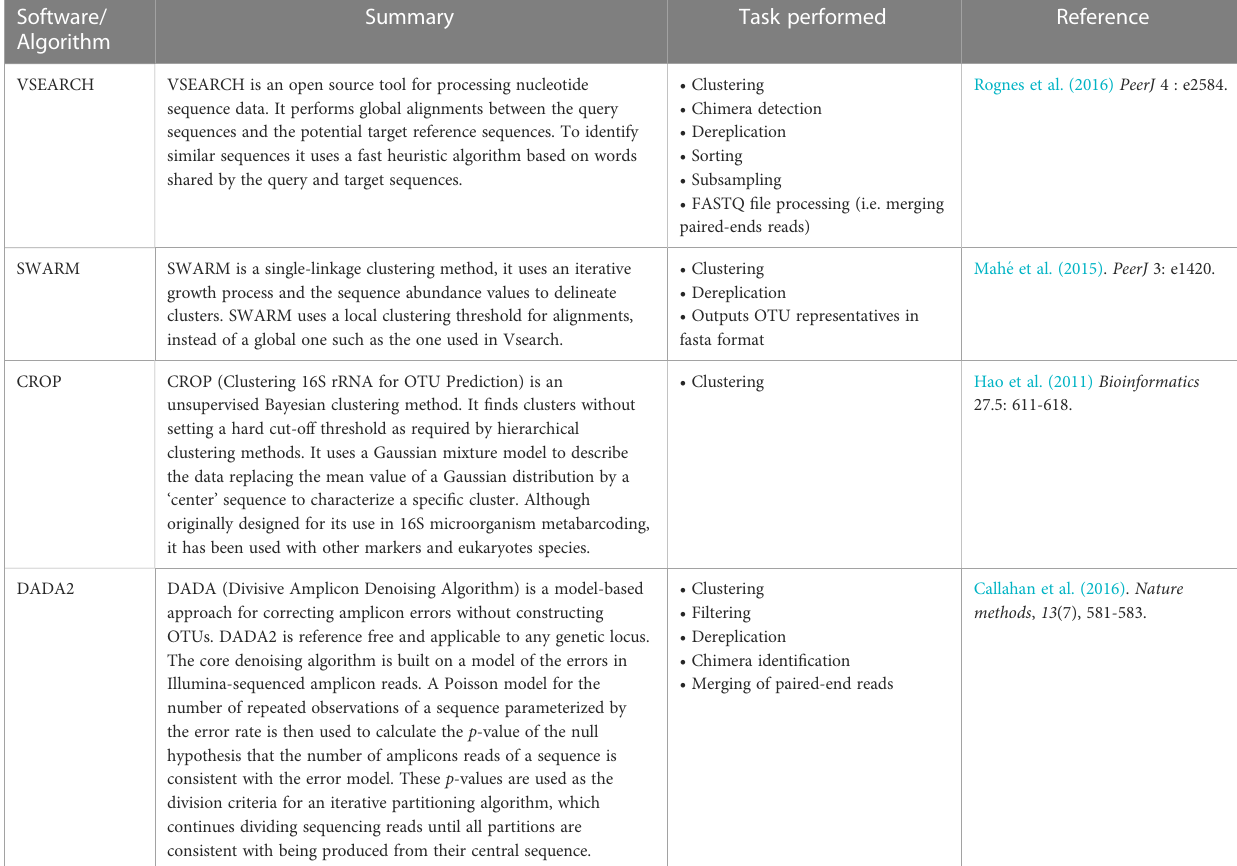
TABLE 1 Most common algorithms used for the clustering step in metabarcoding eDNA analyses. Software/ Algorithm